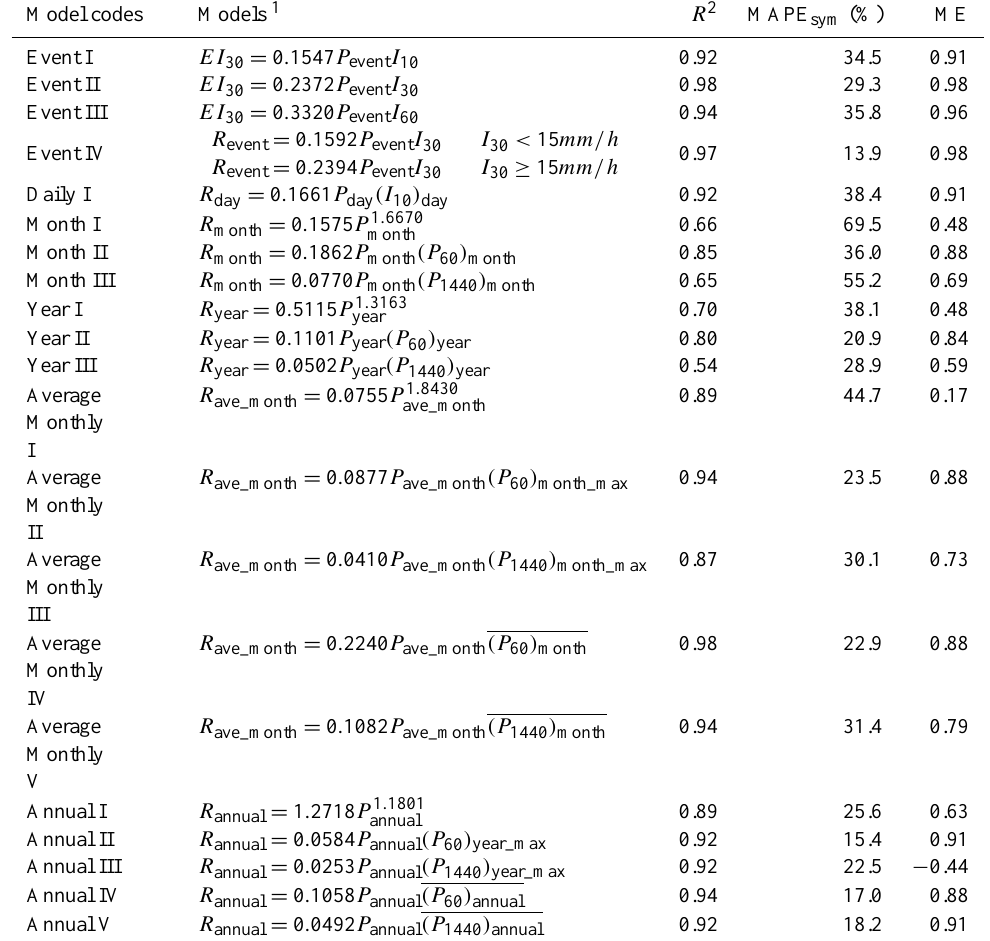
Table 4. Models calibrated in this study and their prediction capabilities determined using the validation stations – the symmetric mean absolute percentage errors, MAPE sym , and Nash–Sutcliffe model efficiencies,